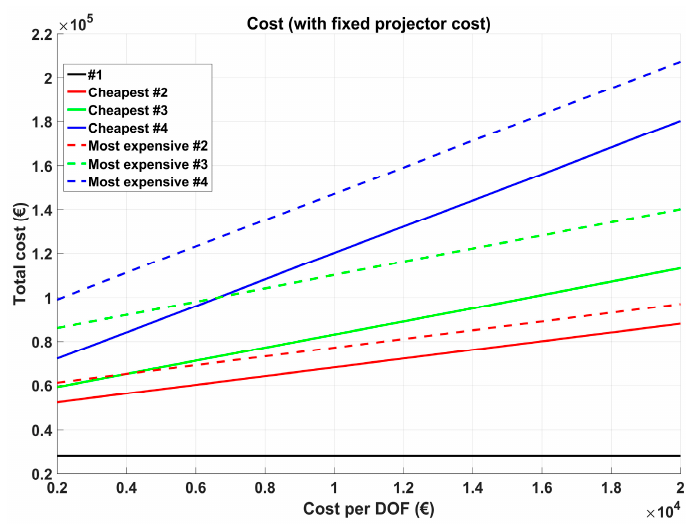
Figure 11. Cost comparison ( € ) with fixed C